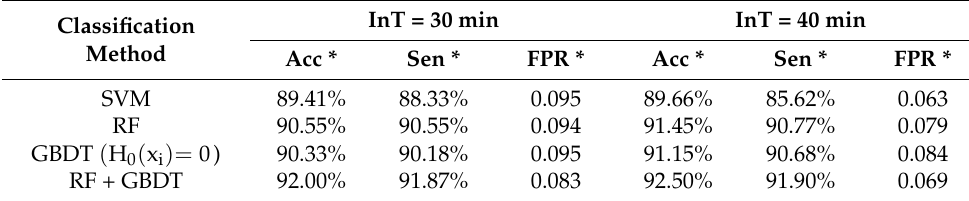
Table 4. Comparison of evaluation metrics of different